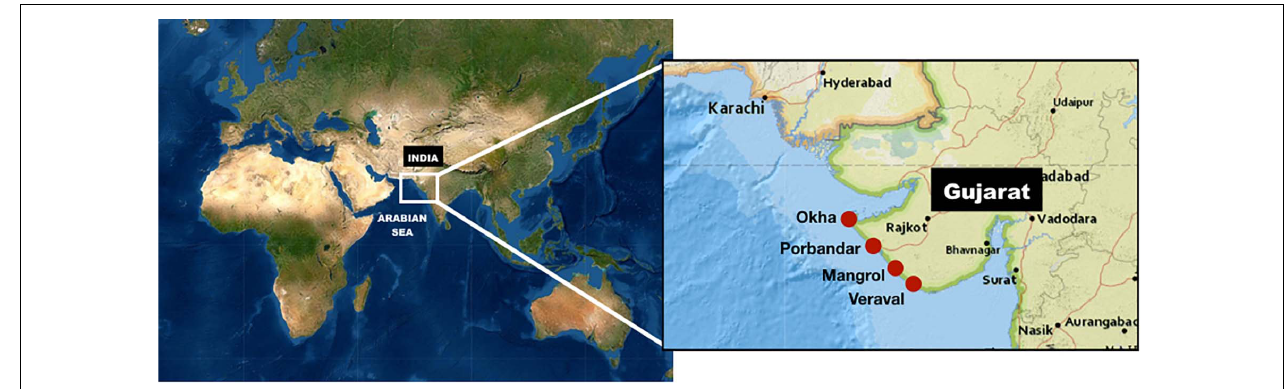
FIGURE 1 | Sampling sites located along the western coast of Gujarat, India. The four sampling locations -Okha, Veraval, Mangrol, and Porbandar – were selected due to the high volume of elasmobranch landings reported previously in the